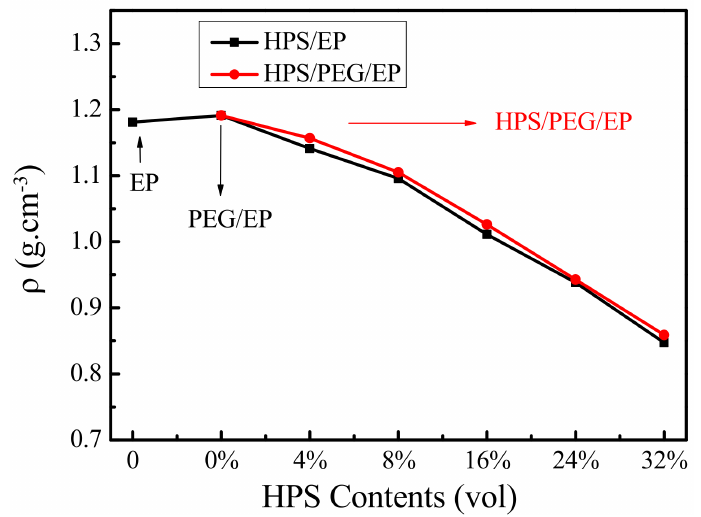
Figure 2. The densities of the pure EP, PEG/EP, HPS/EP and HPS/PEG/EP